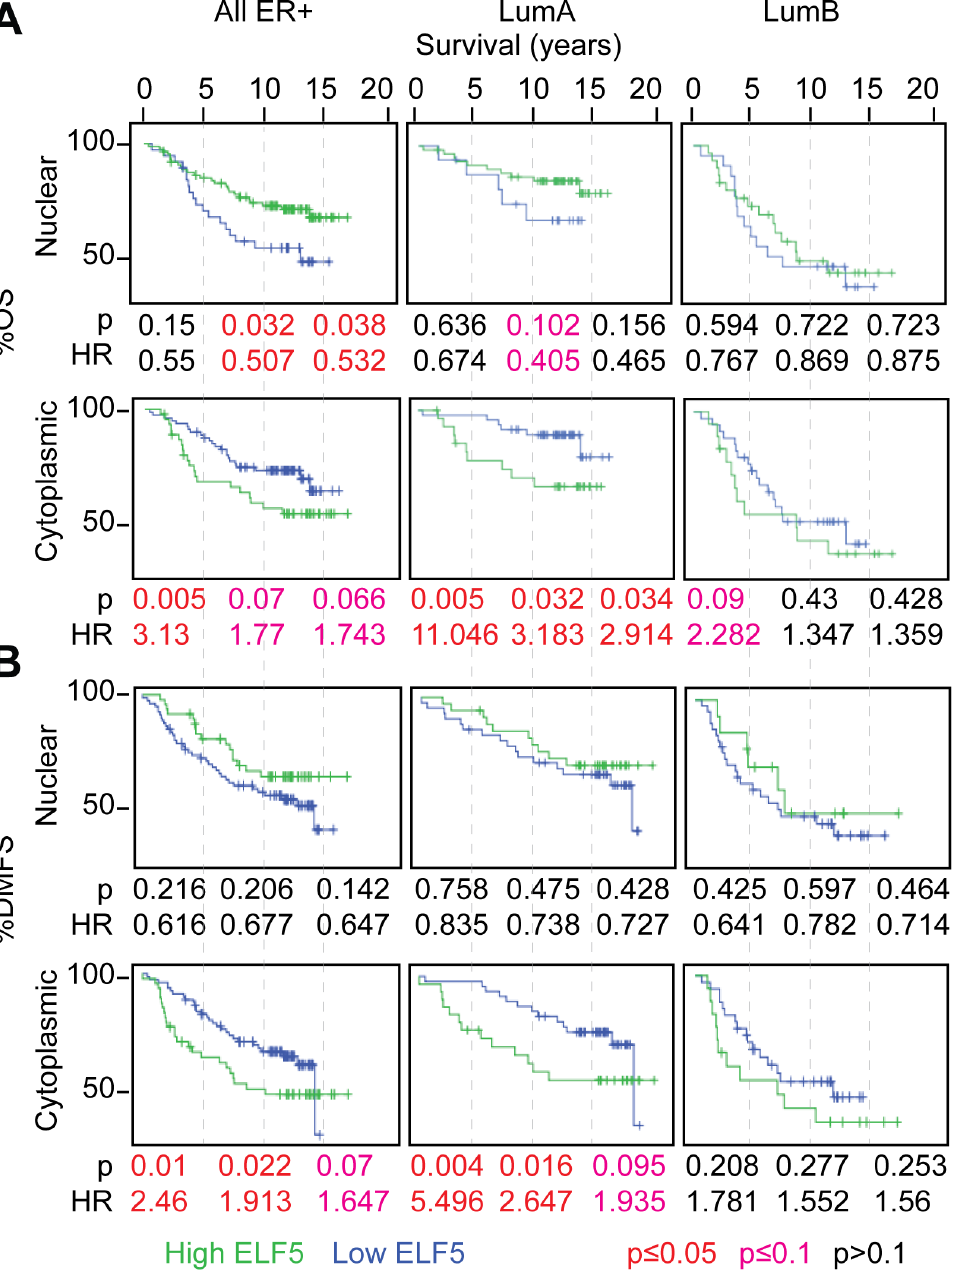
Fig 8. Elf5 immunohistochemistry as a predictor of luminal breast cancer survival. ELF5 was measured by immunohistochemistry in the cytoplasm and nucleus of tumors in a subset of ER+ samples from the Nottingham breast cancer series. Panel A , overall survival (OS) and Panel B distant metastasis free survival (DMFS). Hazards ratio (HR) and Log Rank p -value (p) are given for 5, 10, and 15 y of follow-up. Tumors are split into high ELF5 expression (green) and low Elf5 expression (blue) by XTile and p -values are black where > 0.1, red where (cid:1) 0.05, and pink where 0.05 –